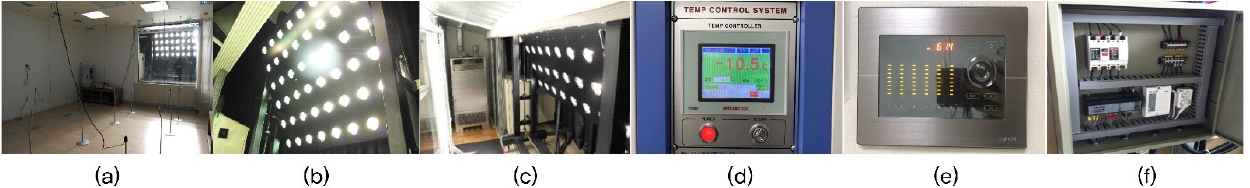
Figure 5. Environment for performance evaluation: ( a ) Testbed, ( b ) Artificial Solar Light Radiation Apparatus, ( c ) Chamber thermostat, ( d ) Chamber temperature controller, ( e ) Light dimming controller, ( f ) Energy monitoring system.